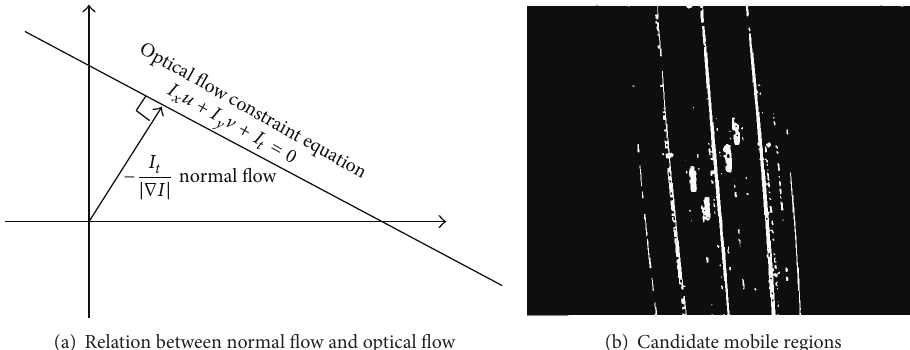
Figure 5: Candidate mobile regions.